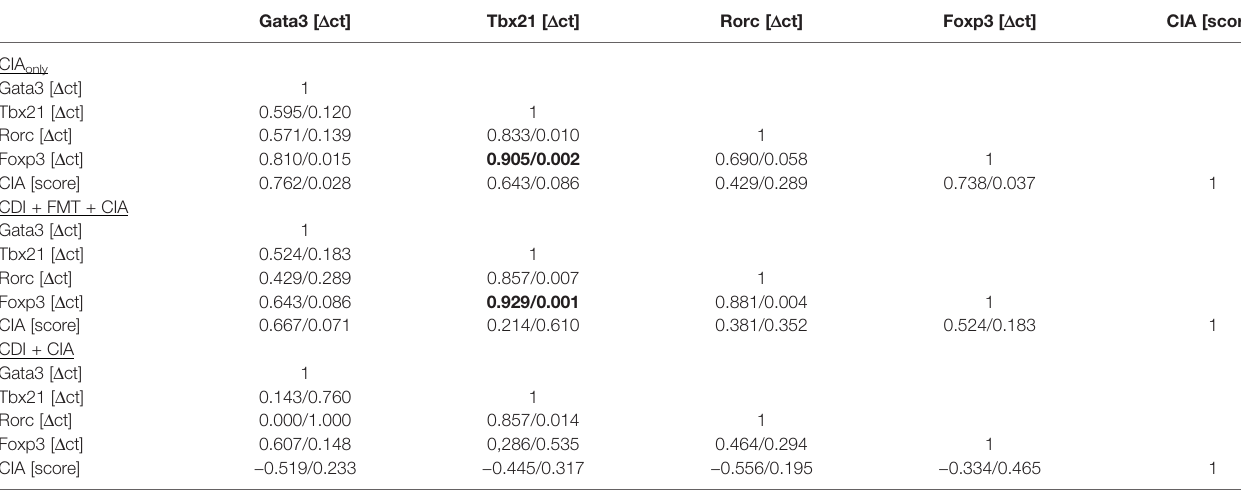
Correlation coef fi cients/p-values resulting from Spearman correlation analyses. According to Bonferroni correction for multiple comparisons, p-values < 0.0033 were considered signi fi cant. Values in bold highlight statistically signi fi cant